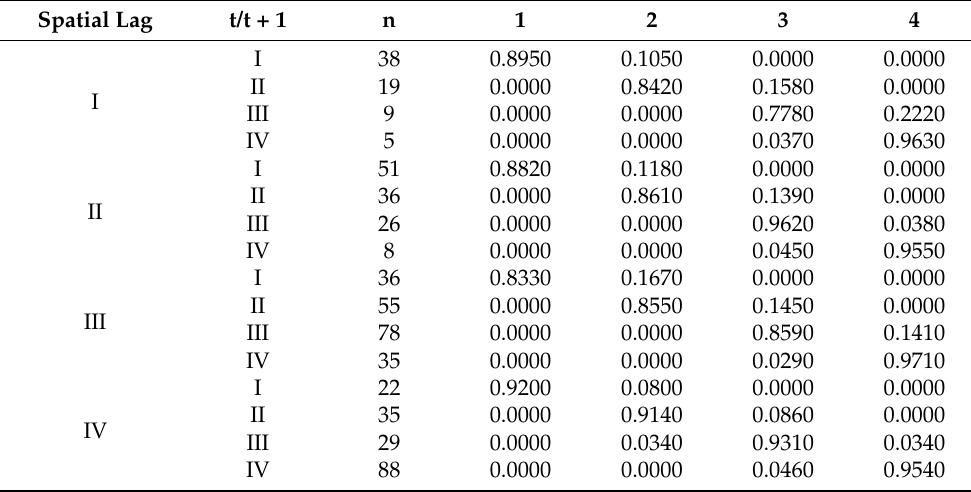
Table 4. Spatial Markov probability transfer matrix of China’s carbon emissions from 2000 to 2020. Spatial